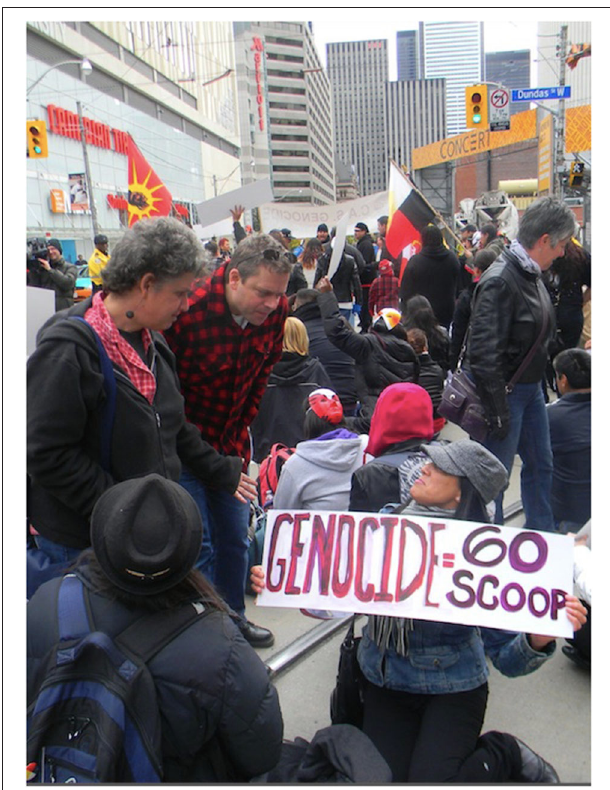
FIGURE 2 | Two sympathetic passers-by stop to talk with 60s Scoop survivor, Angela Ashawasegai, at a rally in Toronto in 2011. Like most Canadians, they had never heard of the 60’s Scoop or of the historical abuses of Indigenous children at the hands of White adoption and foster families until rallies and news media started drawing attention to it. Angela is now a certified trauma therapist, specializing in 60’s Scoop trauma & Complex PTSD.